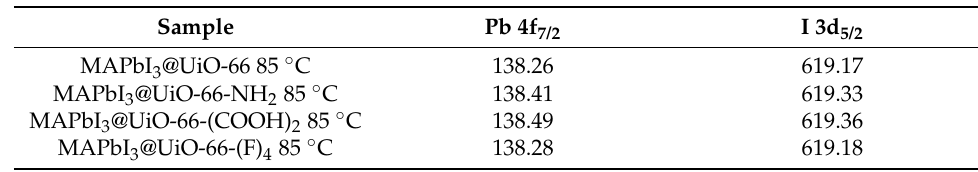
Table 2. Positions of the Pb 4f 7/2 and I 3d 5/2 peaks of the MAPbI 3 @MOF samples before and after annealing.